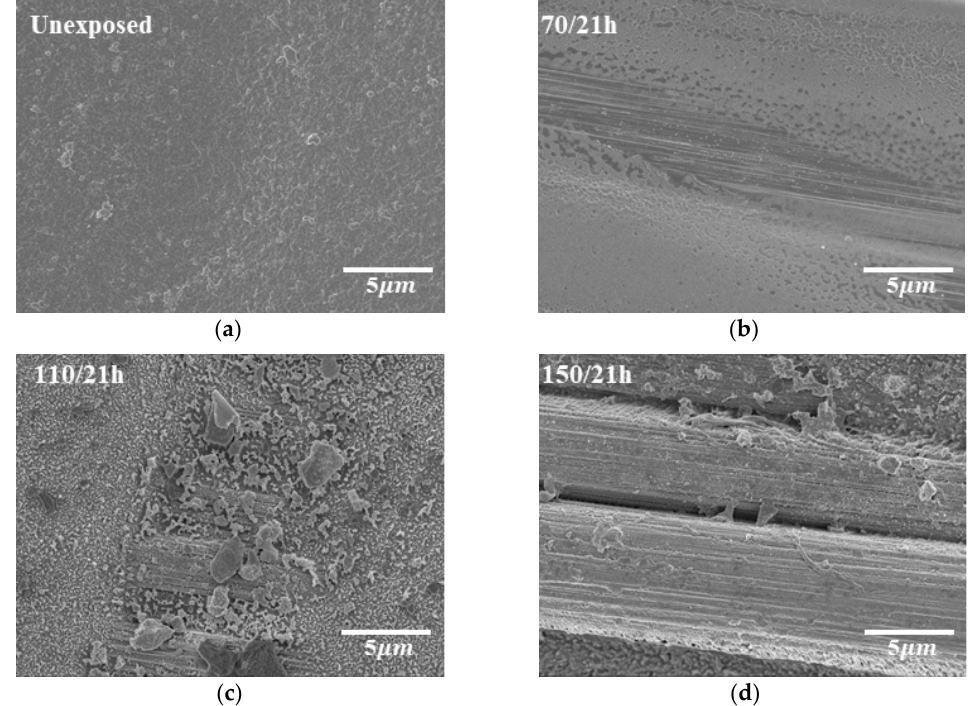
Figure 2. Effects of atomic oxygen (AO) exposure on surface morphology of carbon fiber-reinforced shape memory polymer composites (CF-SMPCs) according to exposure temperature: ( a ) unexposed, ( b ) 70 °C, ( c ) 110 °C and ( d ) 150 °C